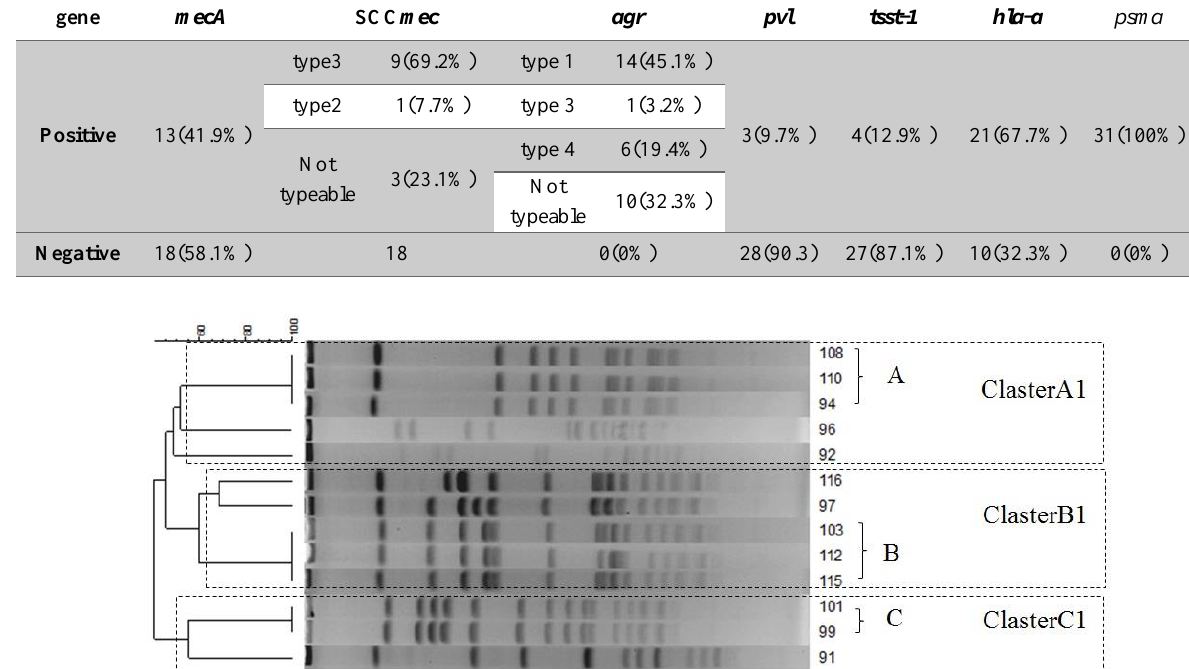
Table 3. The mecA, pvl , tsst-1, hla-α, and psmα genes detection, and SCC mec and agr typing result (n=31)